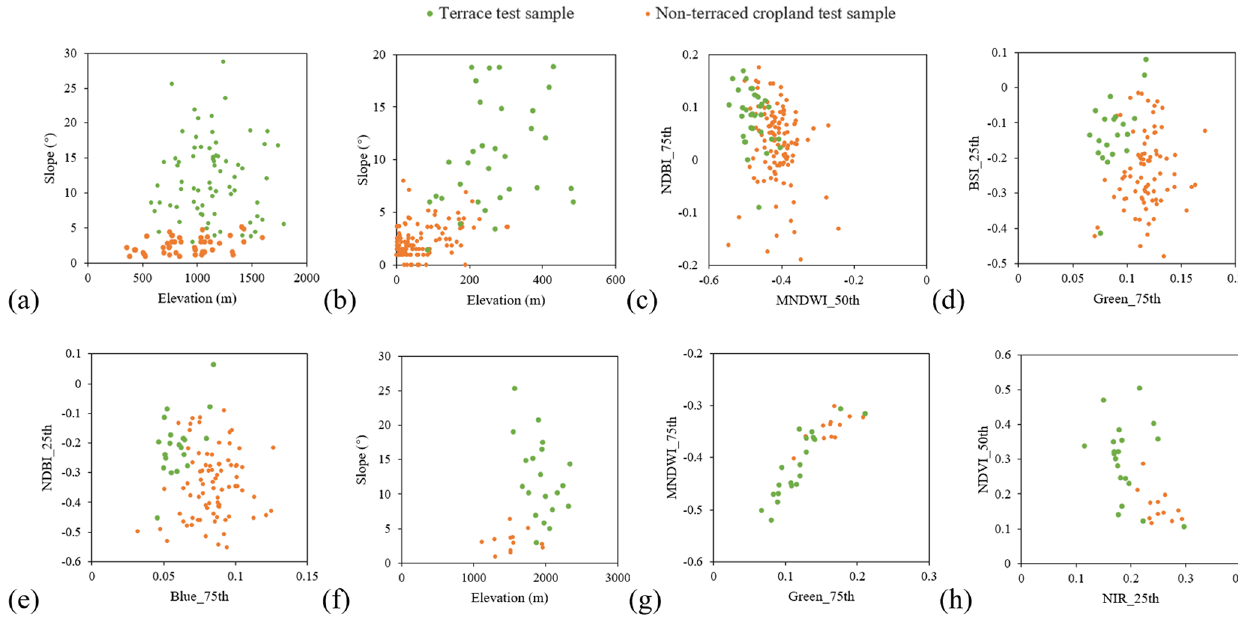
Figure 12. Scatter plots for distinct features of terrace test samples and non-terraced cropland test samples in four provinces: (a) Shanxi,